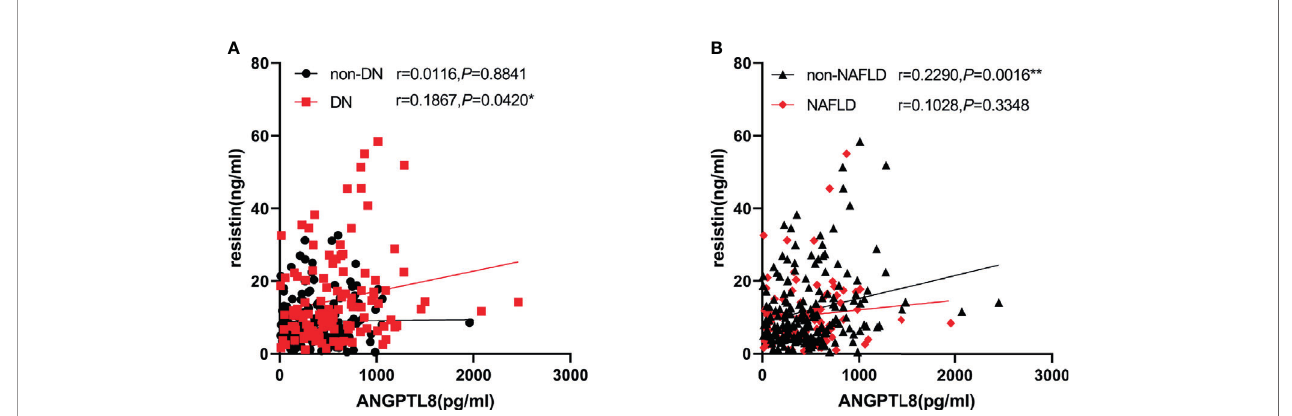
FIGURE 2 | ANGPTL8 was positively associated with resistin in DN in non-NAFLD. (A) , ANGPTL8 was positively associated with resistin in DN. (B) , ANGPTL8 was positively associated with resistin in non-NAFLD, but not in NAFLD group. *p < 0.05 vs. non-DN group. **p < 0.01 vs. NAFLD group.